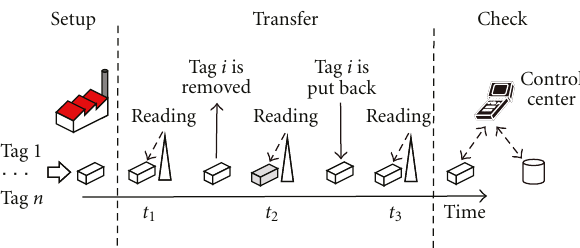
Figure 1: Example of application: supply chain management